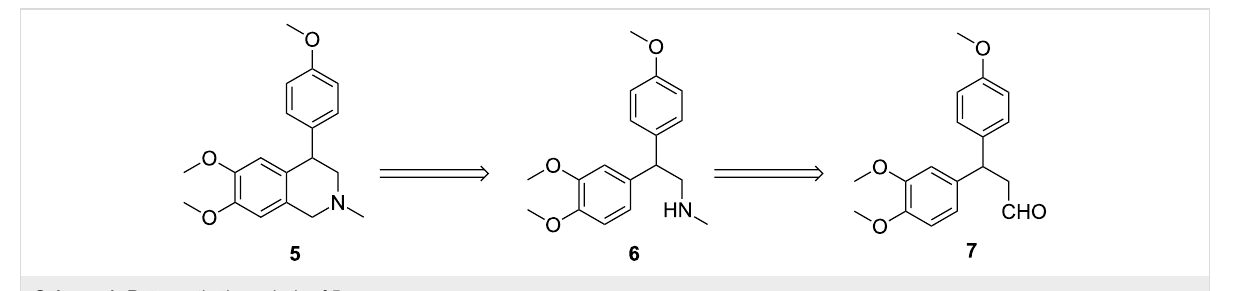
Scheme 1: Retrosynthetic analysis of 5